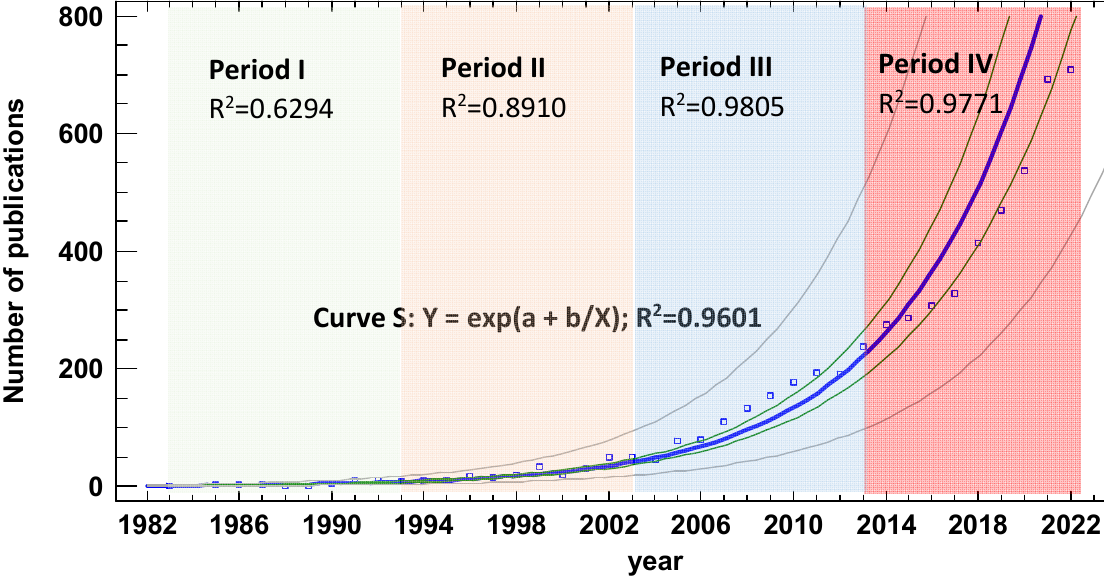
Figure 3. Evolution of the number of publications in silvopastoral system per year (1983–2022). The model fit and the adjusted coefficient of determination used in each stage are shown. R 2 , Coefficient of determination.